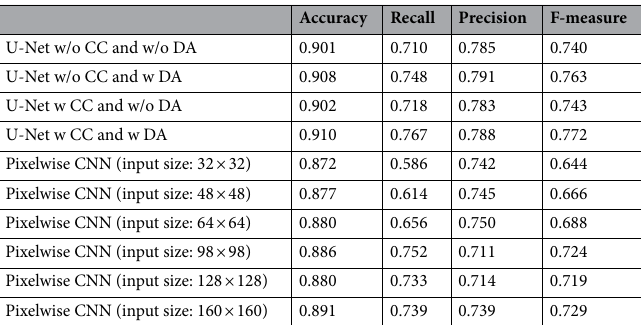
Accuracy Recall Precision